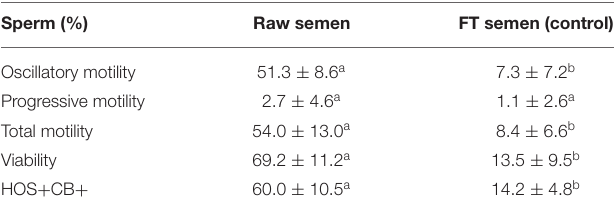
TABLE 1 | Sperm parameters evaluated in raw semen and frozen-thawed (FT) llama semen (untreated control) in ejaculates used for experiment 1. Sperm (%)